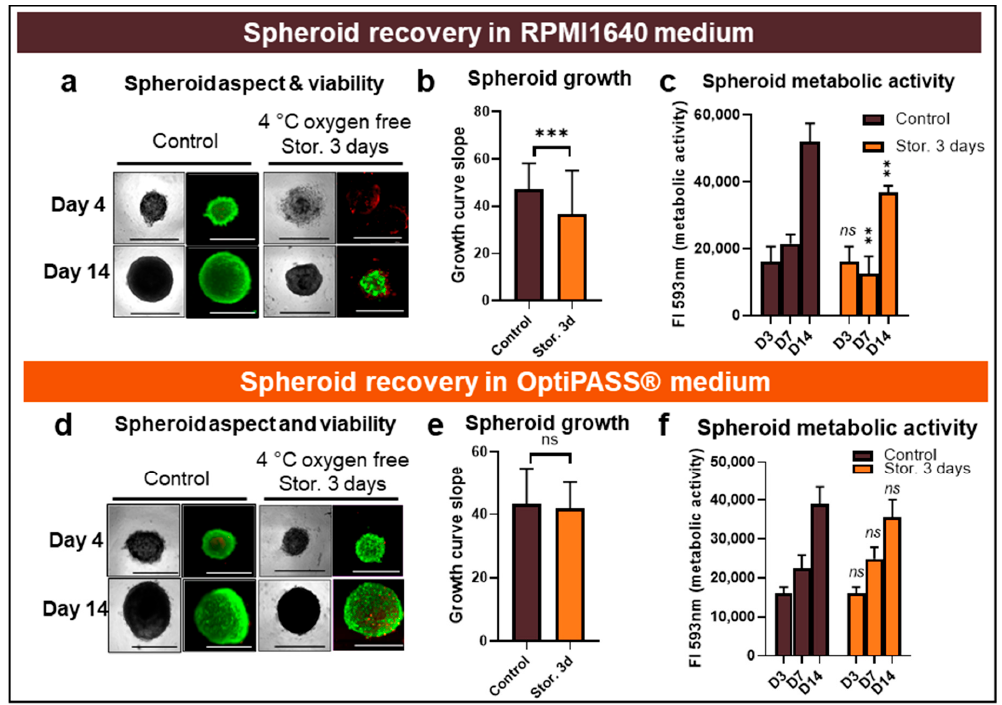
Figure 3. MDA-MB-231 spheroid preservation study after three-day storage at 4 ◦ C and oxygen-free conditions in RPMI1640 and OptiPASS ® media culture. Three-day-old spheroids cultured in normal culture conditions, i.e., 37 ◦ C, 5% CO 2 in RPMI1640 or OptiPASS ® media culture, were exposed to oxygen-free conditions for 3 days at 4 ◦ C. Then, the cultures were exposed again to normal culture conditions in which spheroid recovery was analyzed at day 3, day 4 and day 14. Spheroid integrity aspect and size ( a ) in RPMI and ( d ) in OptiPASS ® were analyzed with bright field microscopy and object size algorithm (Cytation™3MV, Gen5, BioTek ® , M = 4X, scale bar = 1000 µ m). Spheroid cell viability after storage was studied by Live/Dead ® tests ( a ) in RPMI and ( d ) in OptiPASS ® with green fluorescence, for viable cells and red fluorescence, as well as for dead cells, using Cytation™3MV equipped with GFP and IP fluorescence cubes (M = 4X, scale bar = 1000 µ m). Spheroid cell proliferation was measured by the growth curve slope analysis between D4 and D14 ( b ) in RPMI and ( e ) in OptiPASS ® . Spheroid metabolic activity after storage ( c ) in RPMI and ( f ) in OptiPASS ® medium culture was quantified using the resazurin tests. For each storage condition, significances compared to nonstored condition were indicated as ns (not significant; p > 0.05), ** p < 0.01, *** p <